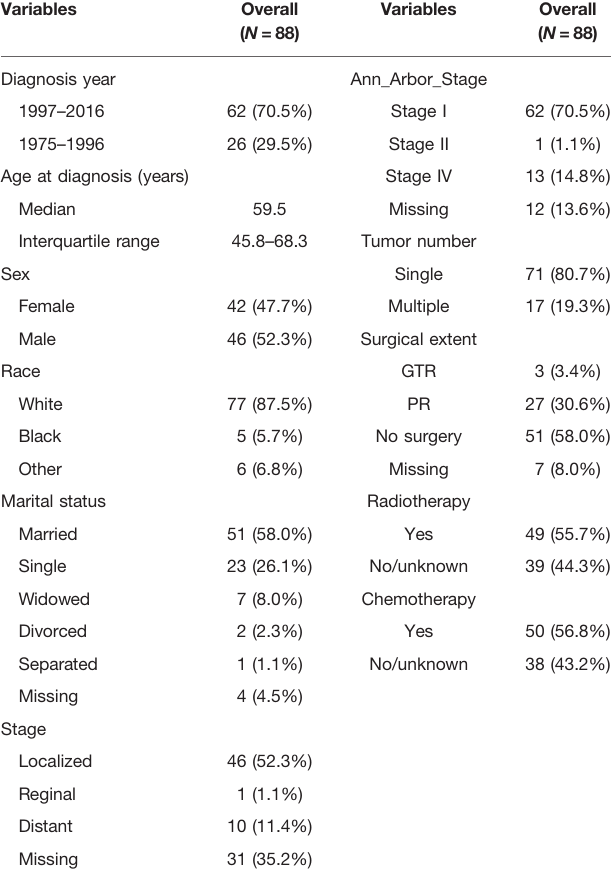
TABLE 1 | Demographic, histological, and therapeutic details of primary brainstem lymphoma.